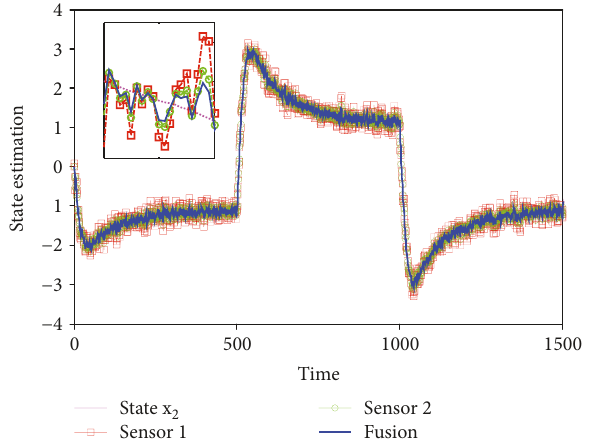
Figure 5: The estimation of x ( L =200).